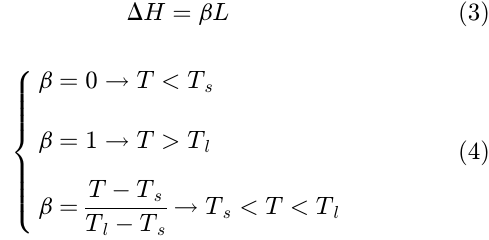
Section 2: Thermometer (Fig. 2c) – Thermometer cover – Thermometer fi lling gas – Sensing element